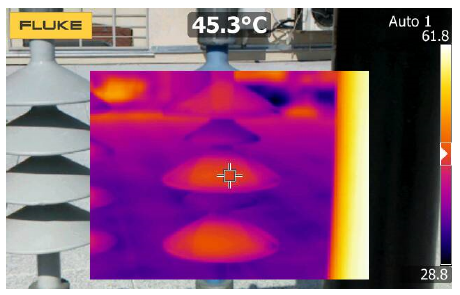
Figure 1. The surface temperature of the composite insulator housing measured with a thermal imaging